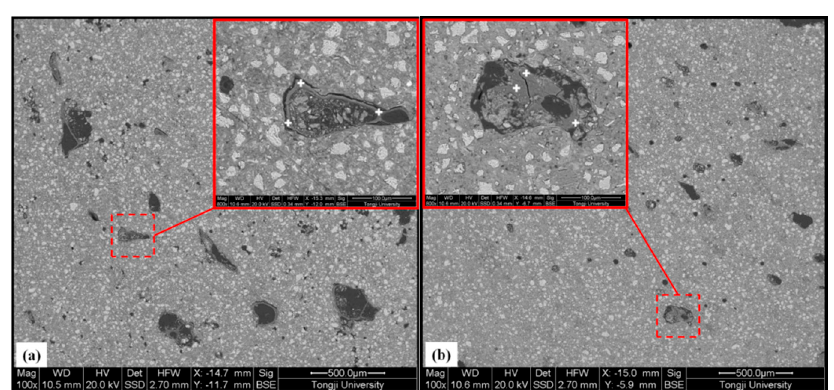
Figure 9. Back-scattered electron images of the CPCA1 with SAPs ( a ) and CPCA2 with SAPs ( b ) at a hydration time of 28 days. The inserting images are local amplification (800 × ) of the typical SAPs particles found in the